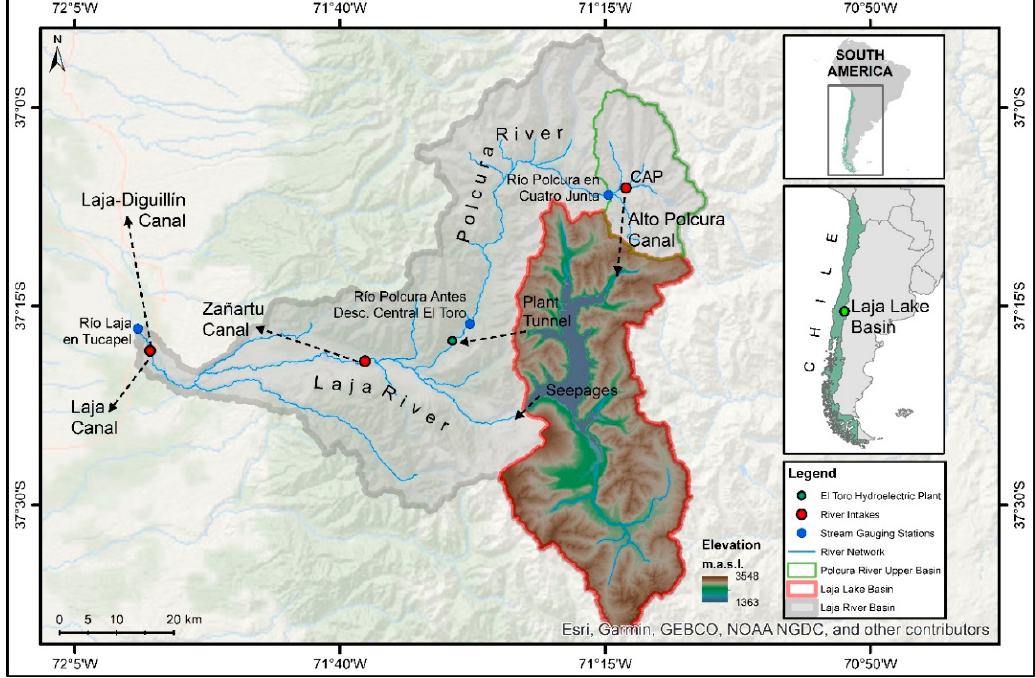
Figure 1. The Laja Lake basin and digital elevation model. Blue lines indicate the river network while blue, red and green points indicate reference locations for the hydrometric stream gauging stations, canal intakes, and the discharge point of El Toro Plant, respectively.